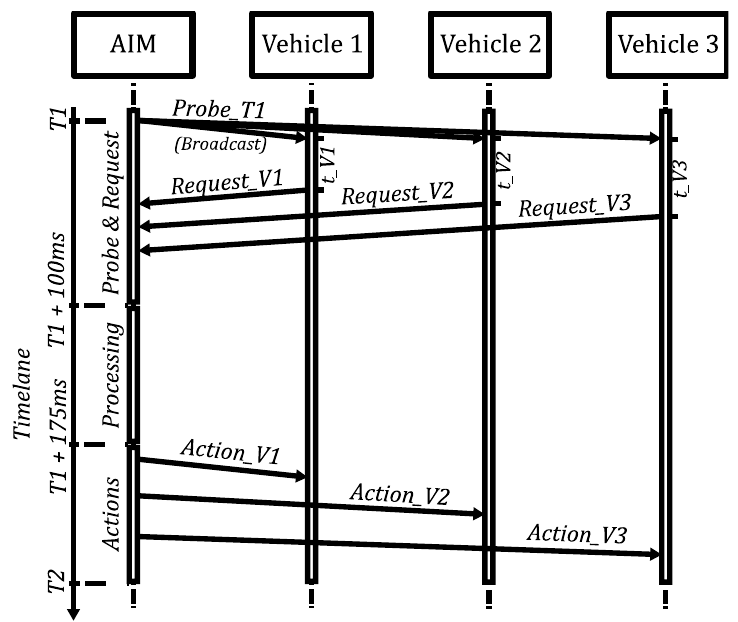
Figure 3. Message diagram proposed for AIM5LA. In this example, there are 3 vehicles to control. The probe message is a broadcast message.